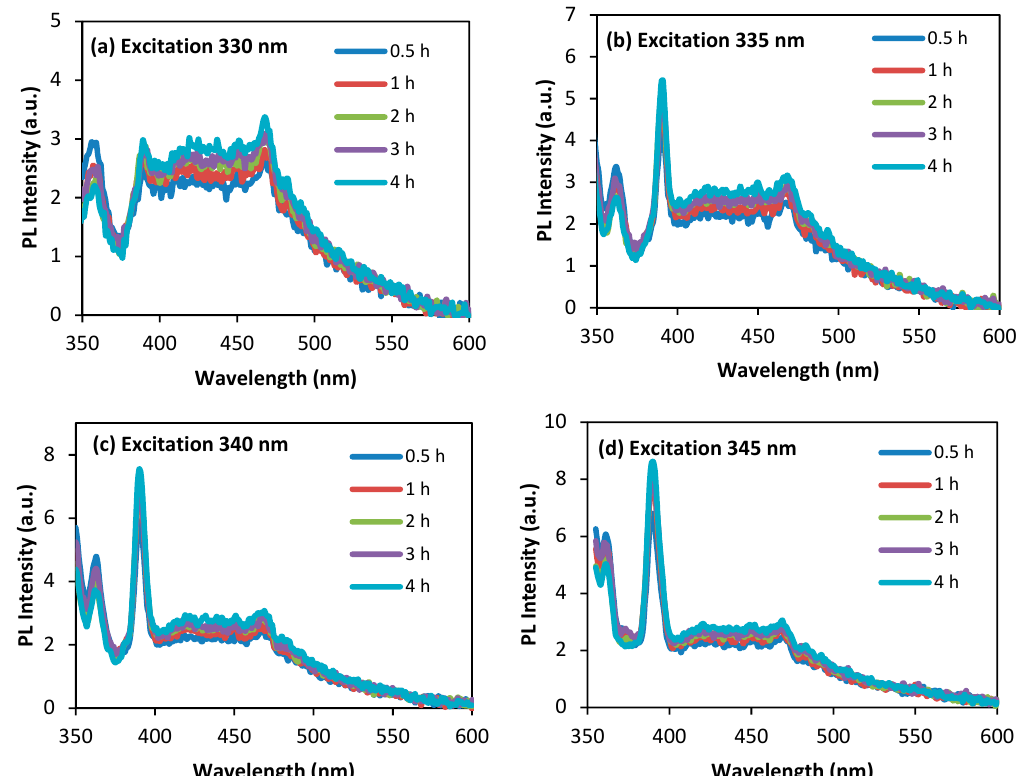
Figure 8. Photoluminescence spectra for Ag/ZnO at different calcination times. Excitation source: ( a ) 330, ( b ) 335, ( c ) 340, ( d ) 345 nm.